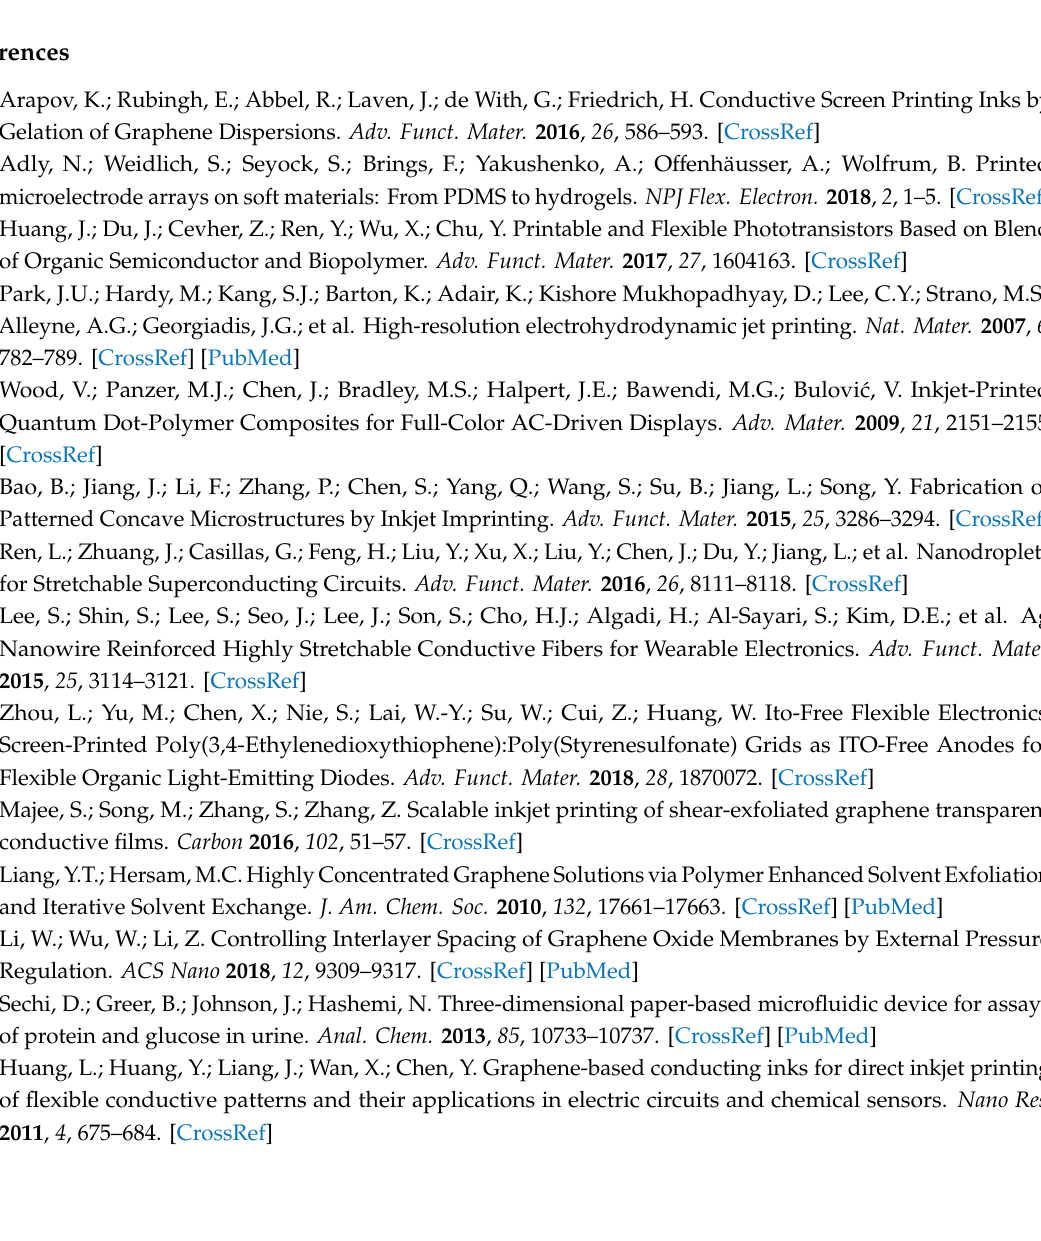
Figure S1: The ID / ID’ ratio in di ff erent batch sizes, Figure S2: Lateral size of graphene platelets produced by wet ball milling, Figure S3: TEM imaging of shear exfoliated graphene, Figure S4: Live–dead cell assay, Figure S5: Cross-section of graphene lines captured by